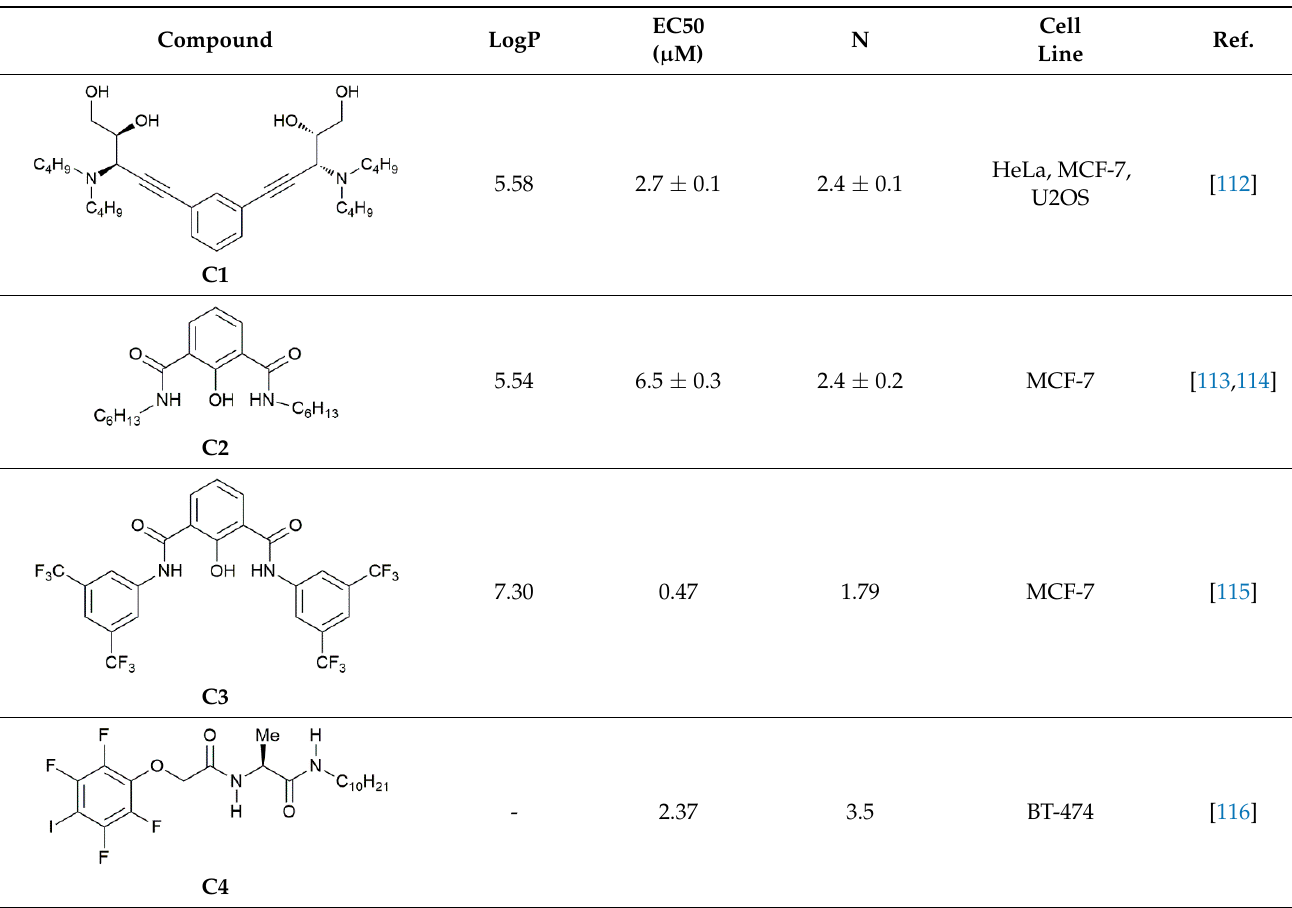
Figure 4. Schematic representation of caspase-mediated apoptosis. Table 2. Cl − selective artificial channels recently developed to induce apoptosis as anticancer agents.